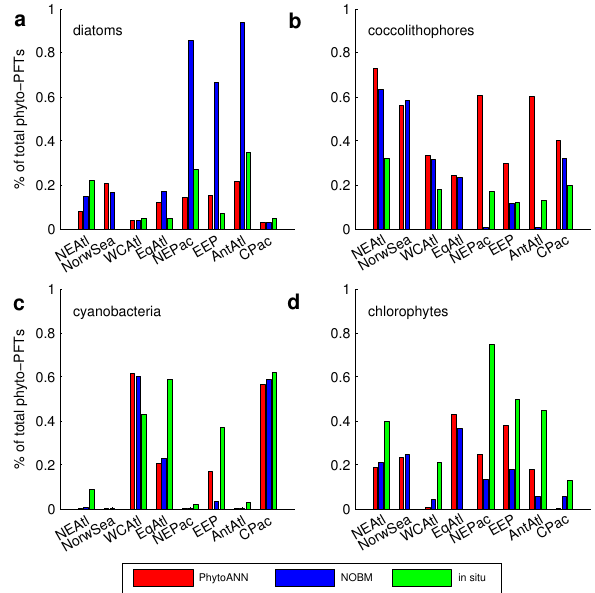
Fig. 6. Approximate box or basin-average comparison between the 1997–2004 annual mean percentage contribution to total Chl biomass of (a) diatoms, (b) coccolithophores, (c) cyanobacteria and (d) chlorophytes according to NOBM (blue), PhytoANN (red) and in situ (green) estimates. In situ estimates were derived from both C- and Chl-based measurements. Here, estimates were derived from a combination of data collected by Gregg et al. (2003) (http://gmao. gsfc.nasa.gov/research/oceanbiology/data.php) and EEP data from Taylor et al. (2011, their Table